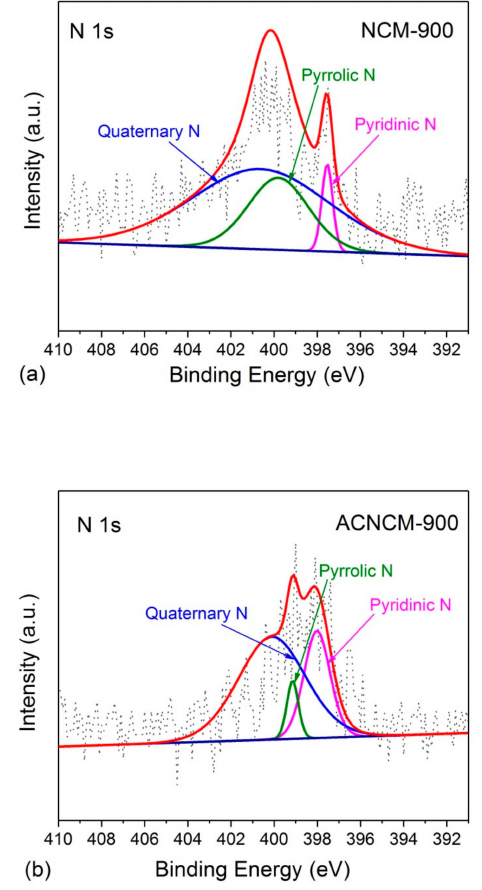
Figure 4. XPS spectra of nitrogen-doped mesoporous carbons ( a ) NCM-900 and ( b )